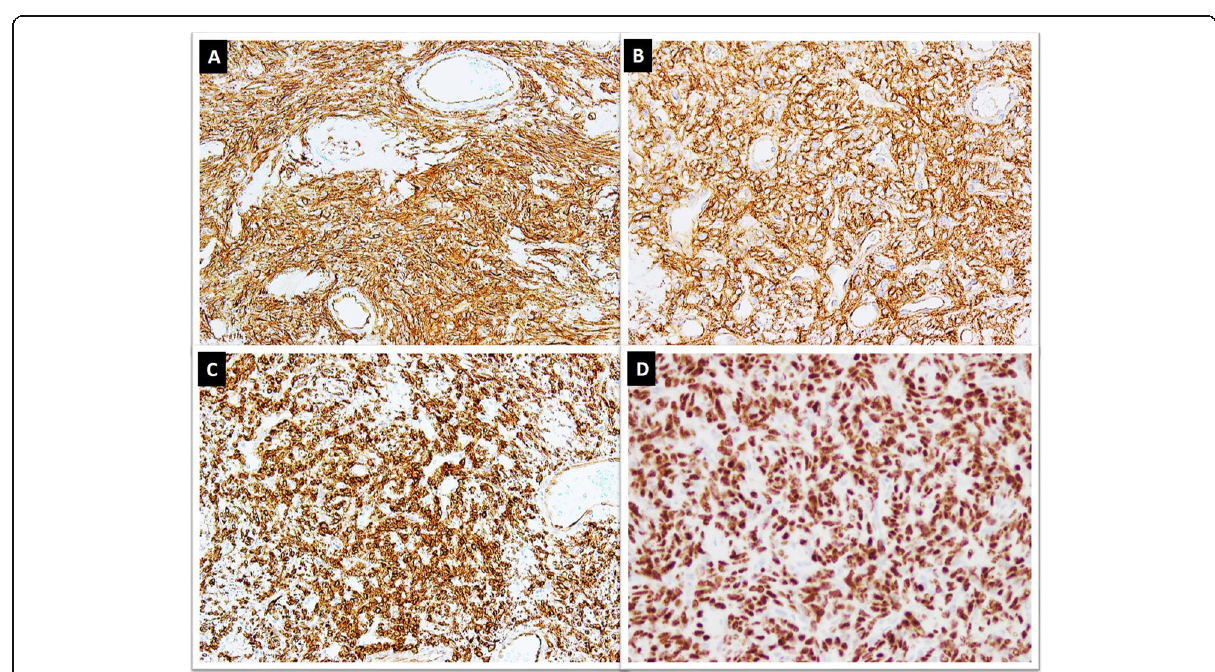
Fig. 6 Tumor cells showing positive staining for, a . CD34, b . CD99, c . BCL2 and, d . nuclear staining for STAT6 IHC